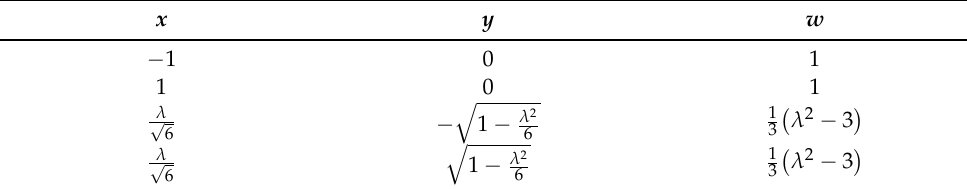
Table 1. Critical points of the planar system defined by (114) and (115).